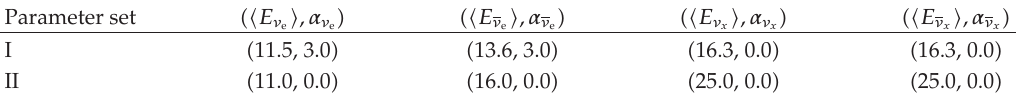
Table 5: Averaged cross sections for the charged-current neutrino-nucleus scattering from the even Mo isotopes in units of 10 − 41 cm 2 computed with the neutrino parameters corresponding to set I of Table 4. Nucleus ν e ν NH ν IH ν e ν NH ν IH ex ex ex ex 92 Mo 1.30 8.74 6.54 0.457 0.606 0.934 94 Mo 2.19 0.283 0.645 96 Mo 3.16 11.9 0.196 0.290 0.495 98 Mo 4.20 100 Mo 6.41 25.7 20.0 0.048 0.093